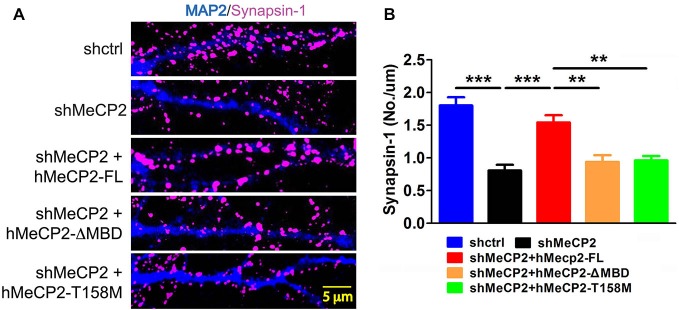
Full length MeCP2 is required for synapse formation. (A) Representative immunostaining images of subcellular distribution of synapsin-1 (pink) in cells infected with shctrl or shMeCP2, co-expression of shMeCP2 with hMeCP2-FL, hMeCP2-ΔMBD or hMeCP2-T158M. (B) Quantification of synapsin-1 puncta density per μm dendrite of neurons infected with the constructs as indicated on the graph. (**p < 0.01 and ***p < 0.001, one-way ANOVA with a post hoc Tukey multiple comparison, number of neurons in (A) and (B): n = 15 (shctrl), 18 (hMeCP2), 13 (shMeCP2 + hMeCP2-FL), 16 (shMeCP2 + hMeCP2-ΔMBD), 15 (shMeCP2 + hMeCP2-T158M) from at least 3 batches).